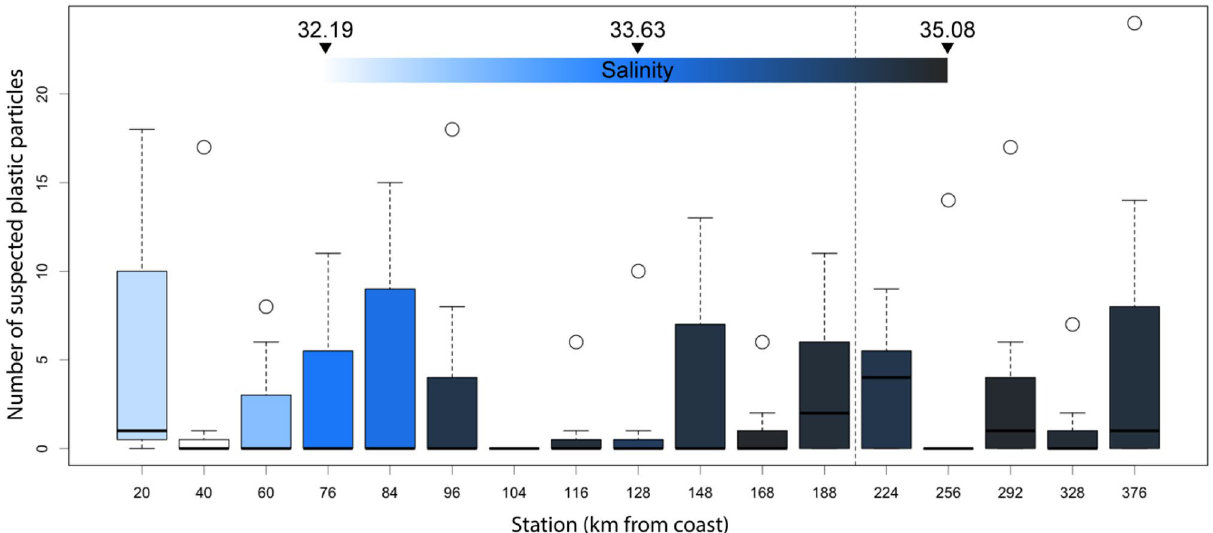
Figure 5. Counts of suspected plastic particles and fibers in vertical plankton hauls along the Svinøy transect, traversing the Norwegian Coastal Current, the Norwegian Atlantic Current, and the south-eastern Norwegian Sea. Here blue hues of colored boxes indicate the average salinity at the fixed station across the seven synoptic transects made, and dashed line after 188 km demarcates the split between the inner and outer segment of the transect as referred to in the text. For interpretation of “box and whisker” plot see Fig. 4